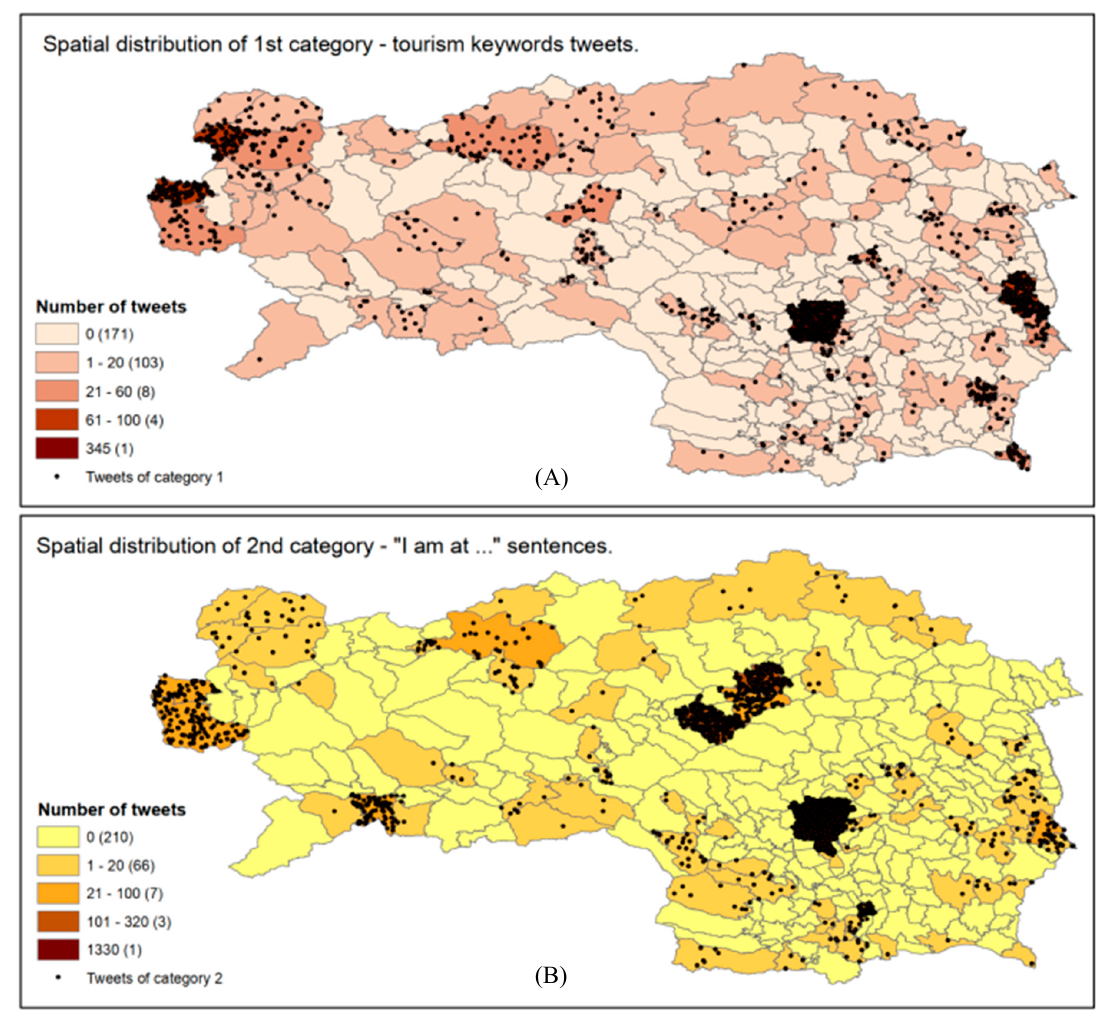
Figure 6. Spatial distribution of the tourism-related tweets according their subgroups. Map ( A ) depicts the number of tweets of category 1, having tourist related keywords. Map ( B ) shows the tweets of category 2—tweets that are of the form “I am at …”. Map ( C ) shows the rest of tourist related tweets—i.e., category